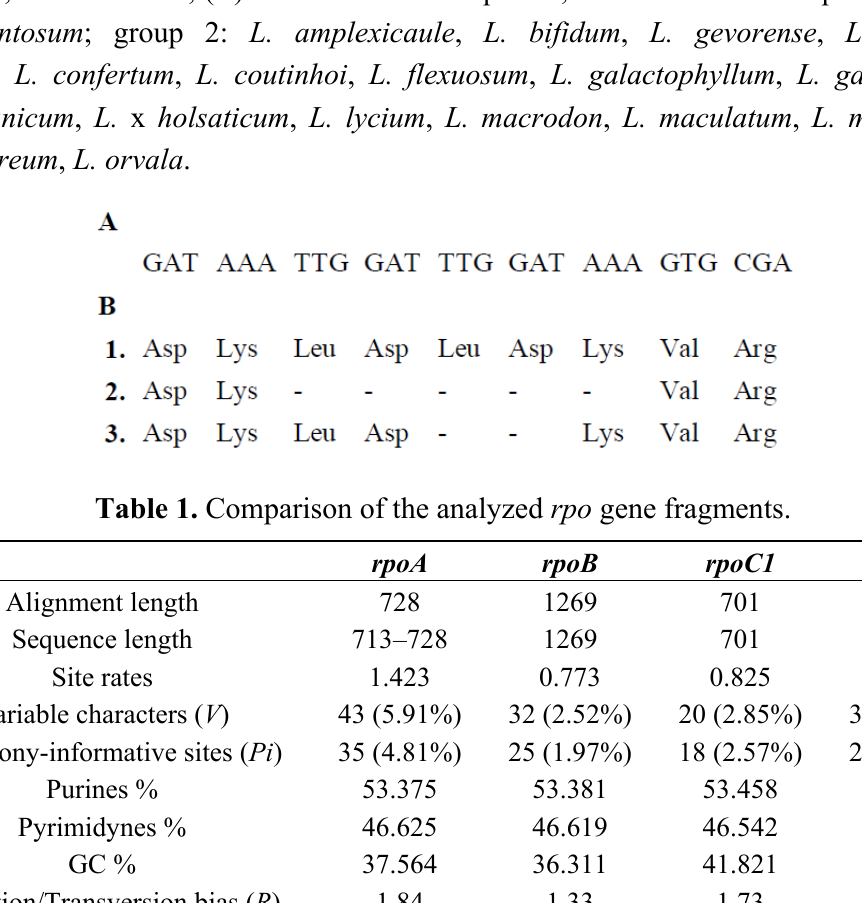
Figure 1. Fragment of the alignment of rpoA gene containing indel. ( A ) The nucleotide sequence; sites 688–714; ( B ) The amino acid sequence; sites 230–238. Group 1: L. album ,